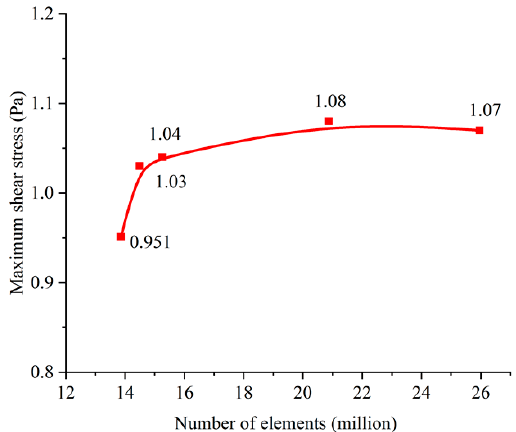
Figure 5. E ff ect of the number of mesh elements on the Fluent 17.0 calculation results. Figure 5. Effect of the number of mesh elements on the Fluent 17.0 calculation results.